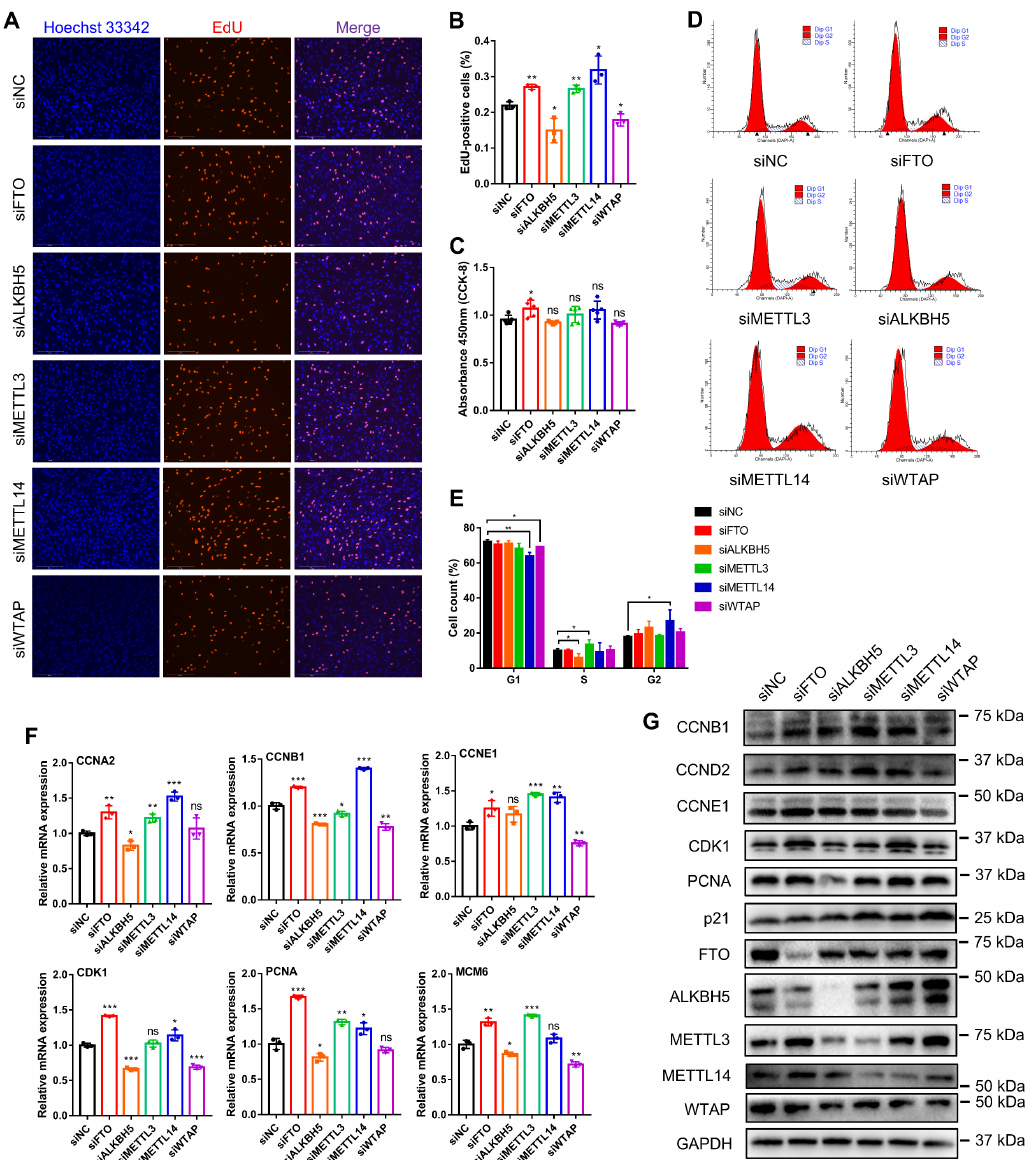
inhibited myoblast apoptosis, while METTL14 knockdown likely had a neutral influence on myoblast apoptosis.